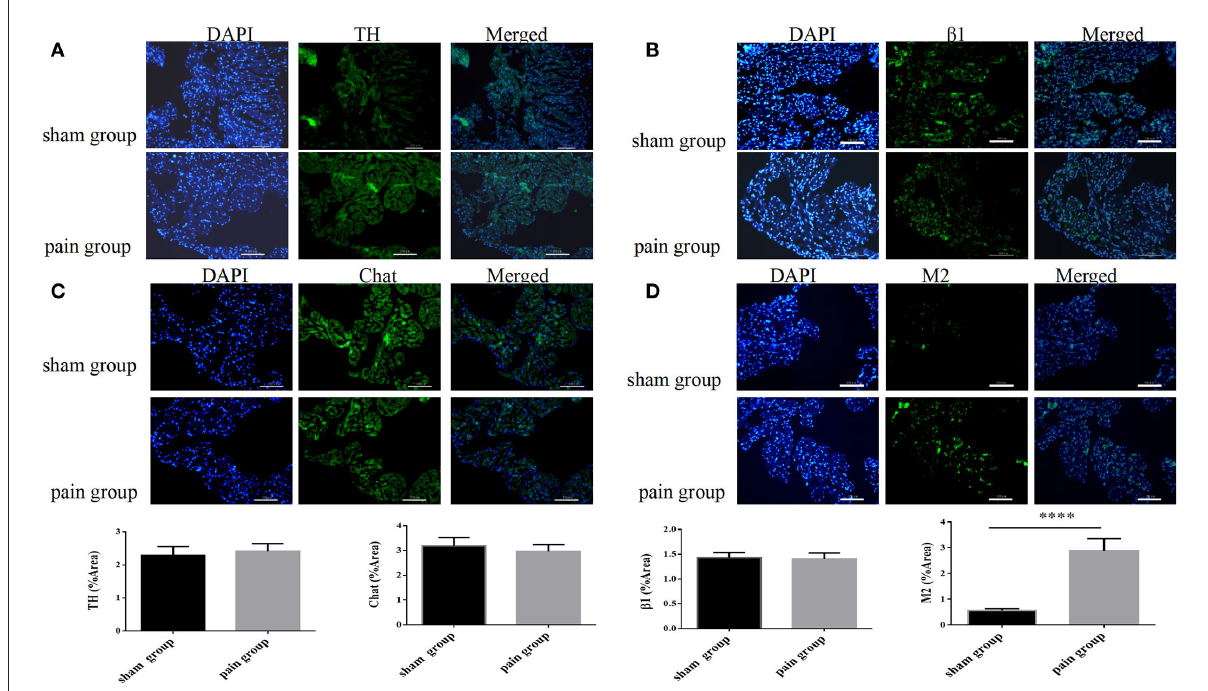
FIGURE6 Autonomic nervous system-related protein expression distribution by immunofluorescence. (A) Tyrosine hydroxylase (TH), (B) choline acetyltransferase (Chat), (C) adrenergic β 1 receptor, and (D) muscarinic acetylcholine M2 receptor expression distribution with immunofluorescence in sham and pain groups. The results are expressed as mean ± standard deviation. The histograms represent values. **** represents p < 0.0001 (two-tailed Student’s t